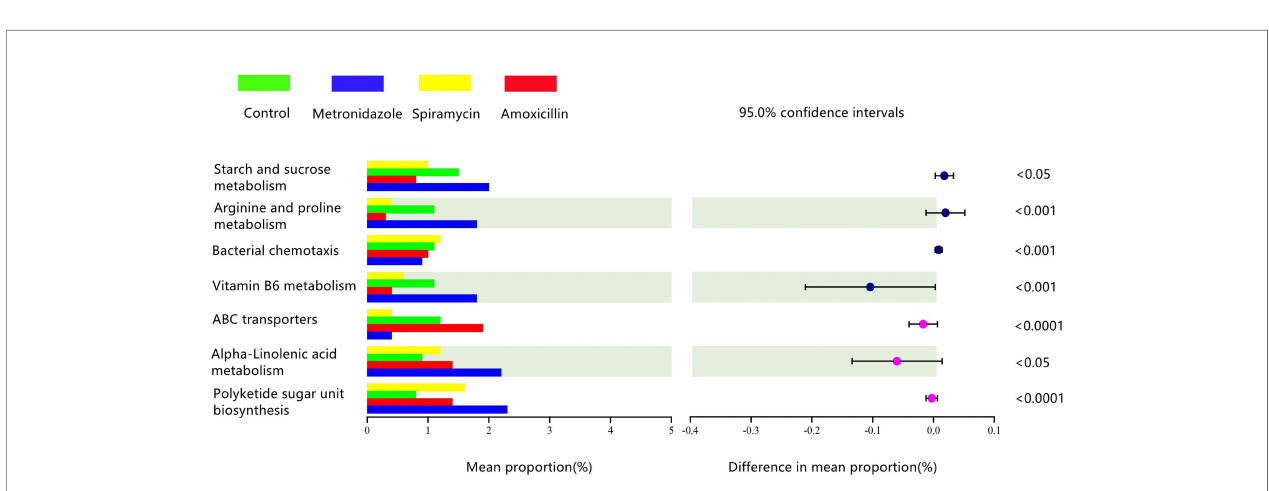
FIGURE 6 | Comparison of predicted gene functions of rats oral microbiota between the Amoxicillin (AMX), Metronidazole (MTZ), Control (Con), spiramycin (SP) groups.